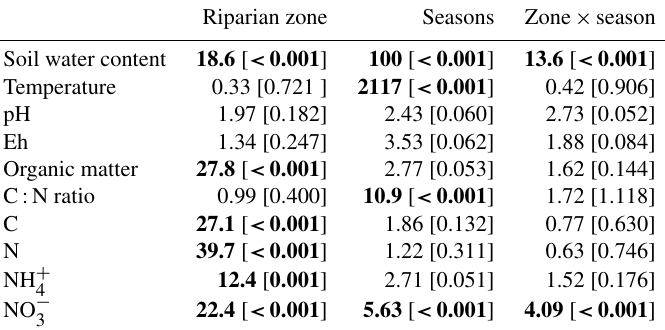
) and nitrate (NO − ) concentrations for 4 3